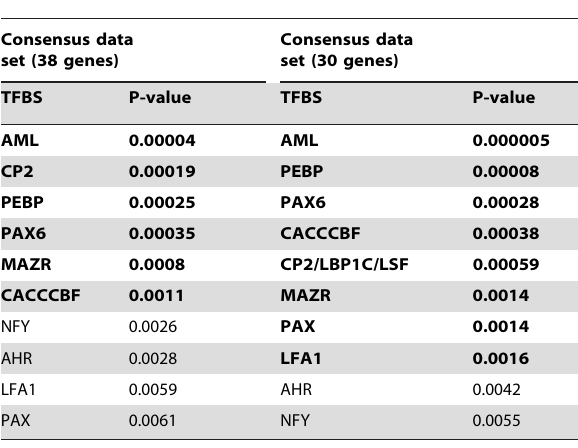
Table 2. Top 10 TFBSs that were found by DEMON in the consensus data set and in the 30 consensus genes that exhibited increased transcription.